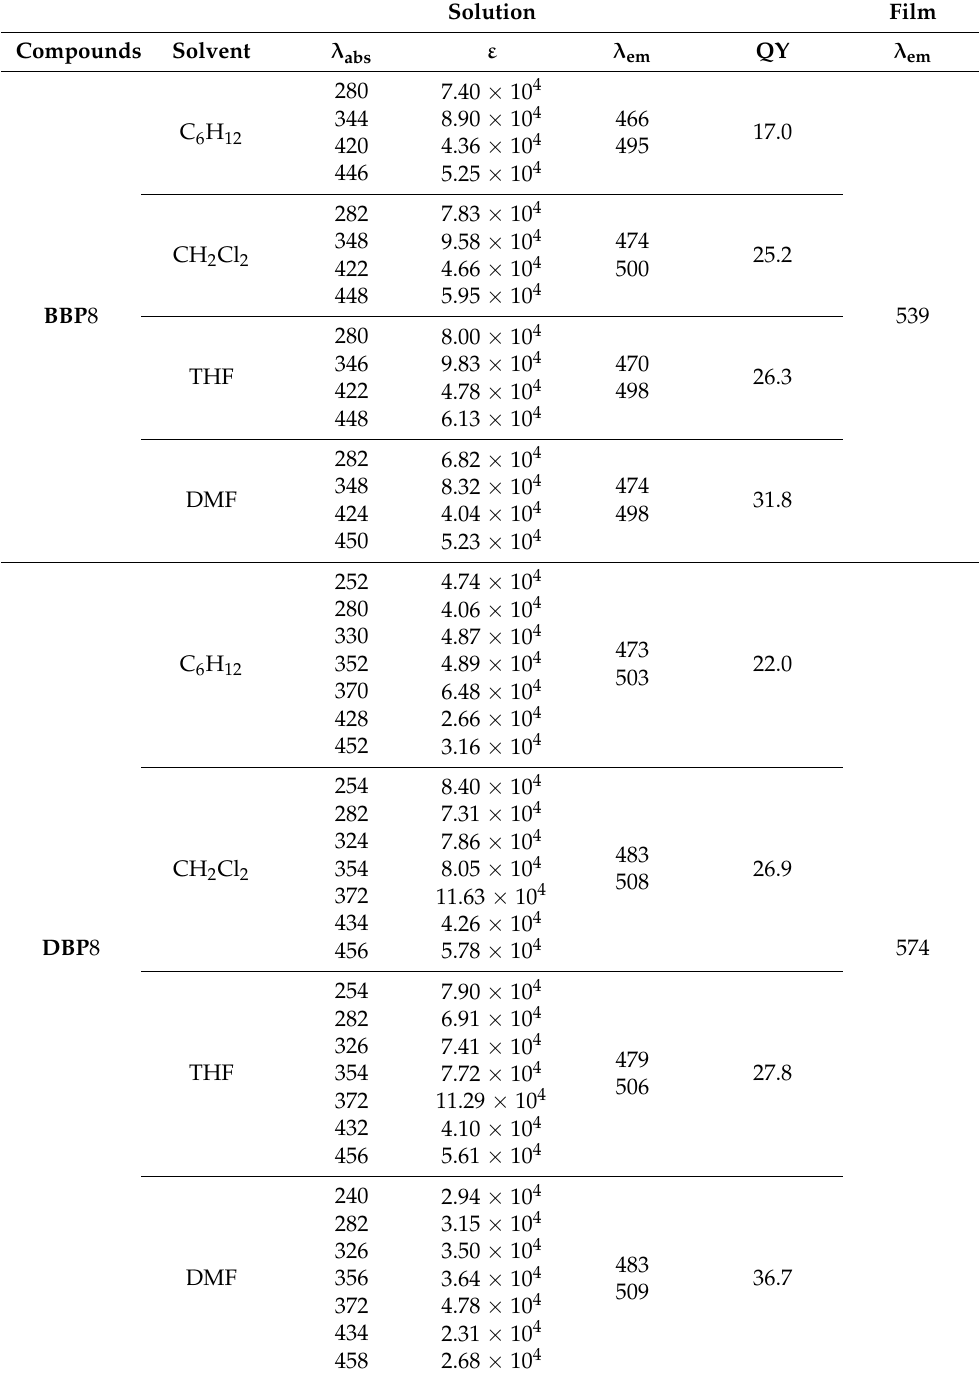
Table 2. Spectroscopic parameters of BBP 8 and DBP 8 in various solvents and thin films a .